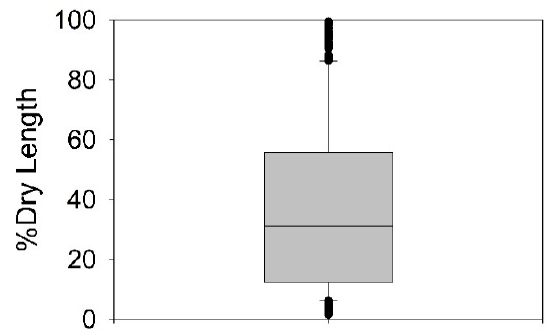
Figure 3. Box plot showing the distribution of the % dry length.